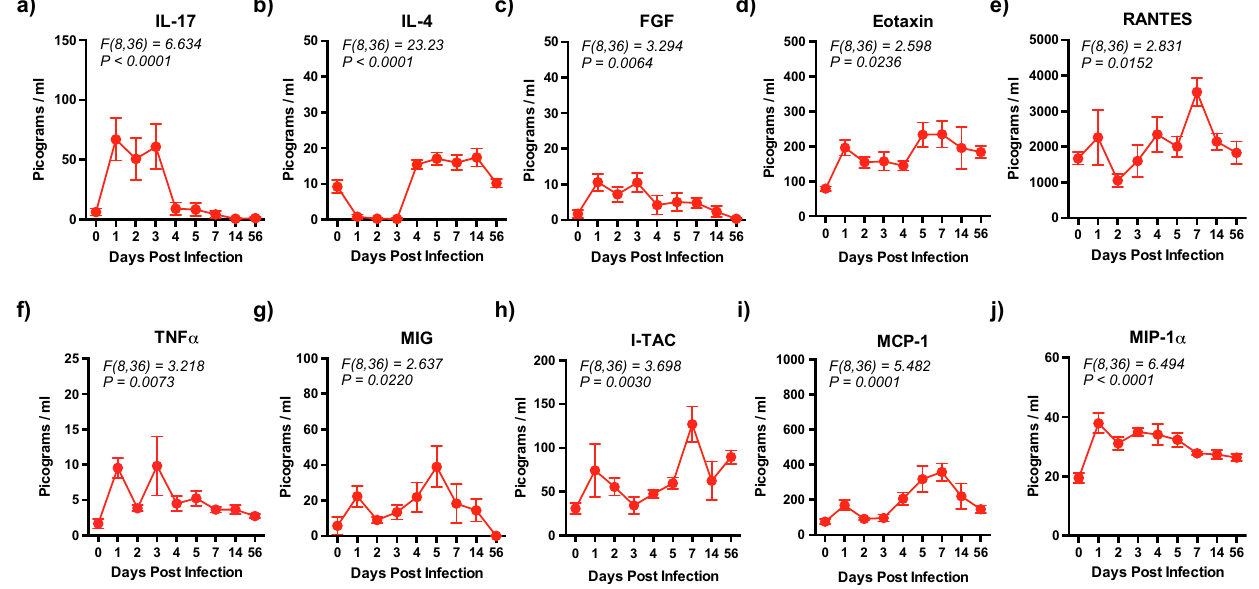
Figure 4. Pro-inflammatory cytokine levels are significantly elevated during the acute phase of coinfection with ZIKV and DENV-2. Kinetics of ( a ) IL-17, ( b ) IL-4, ( c ) FGF, ( d ) Eotaxin, ( e ) RANTES, ( f ) TNF α , ( g ) MIG, ( h ) I-TAC, ( i ) MCP-1, and ( j ) MIP-1 α in plasma that was collected longitudinally from rhesus macaques (n = 5) coinfected with ZIKV and DENV-2. Statistical differences were determined using One-way ANOVA and p < 0 . 05 was considered significant. Error bars represent standard